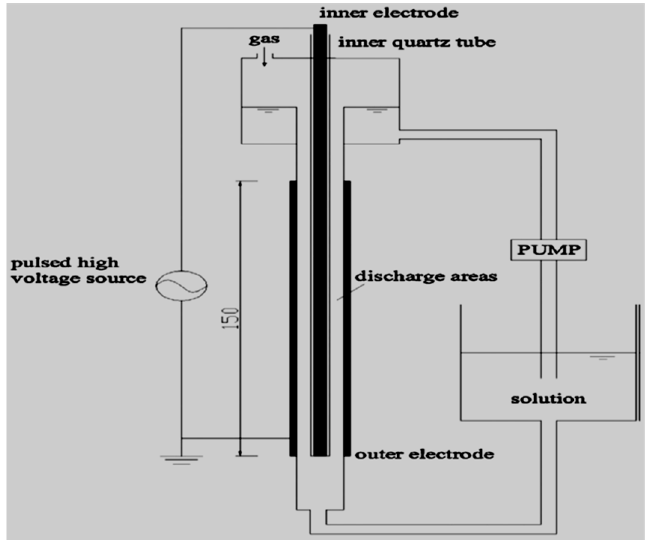
Figure 6. Single-cylinder dielectric barrier discharge reactor used for the degradation of sulfadiazine antibiotics [162].